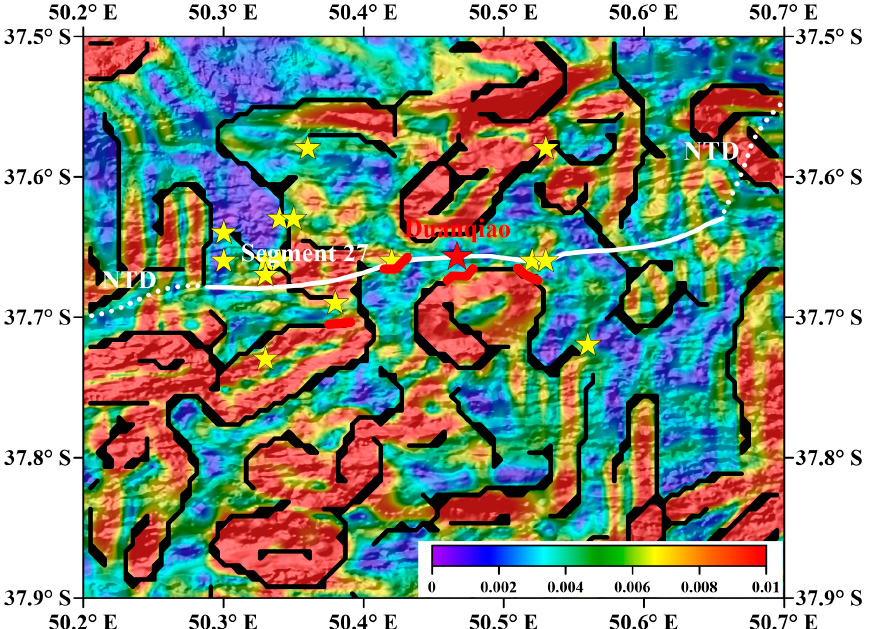
Figure 10. Total Horizontal Derivative (THDR) of the observed gravity anomaly. The solid black lines are boundary detection results of Canny operator. Four solid red lines represent the boundaries related to the Duanqiao hydrothermal field and plume anomalies studied in density profiles (Figure 9). The solid white line and dotted white lines represent segment 27’s axis and two NTDs, respectively. The red star denotes the Duanqiao hydrothermal field. Yellow stars represent several hydrothermal plume anomalies [17].